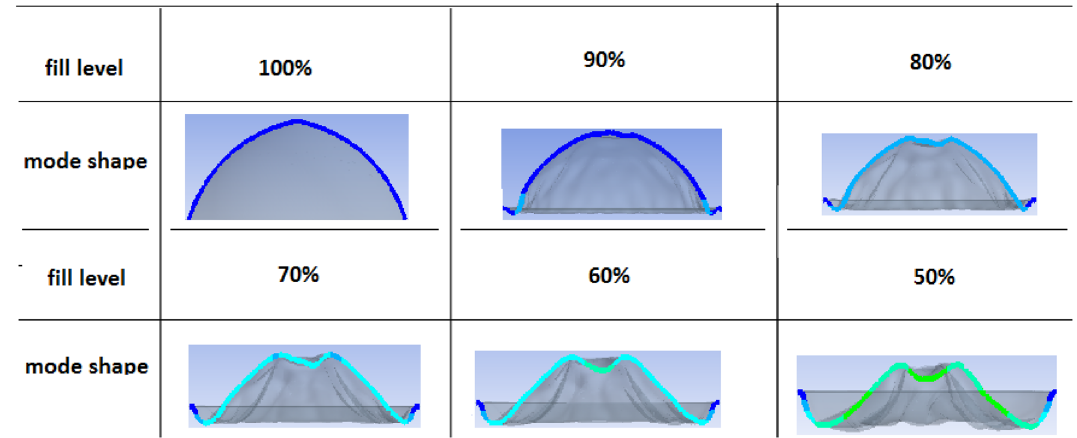
Table 4 The cross section mode shapes of numerical results in different fill